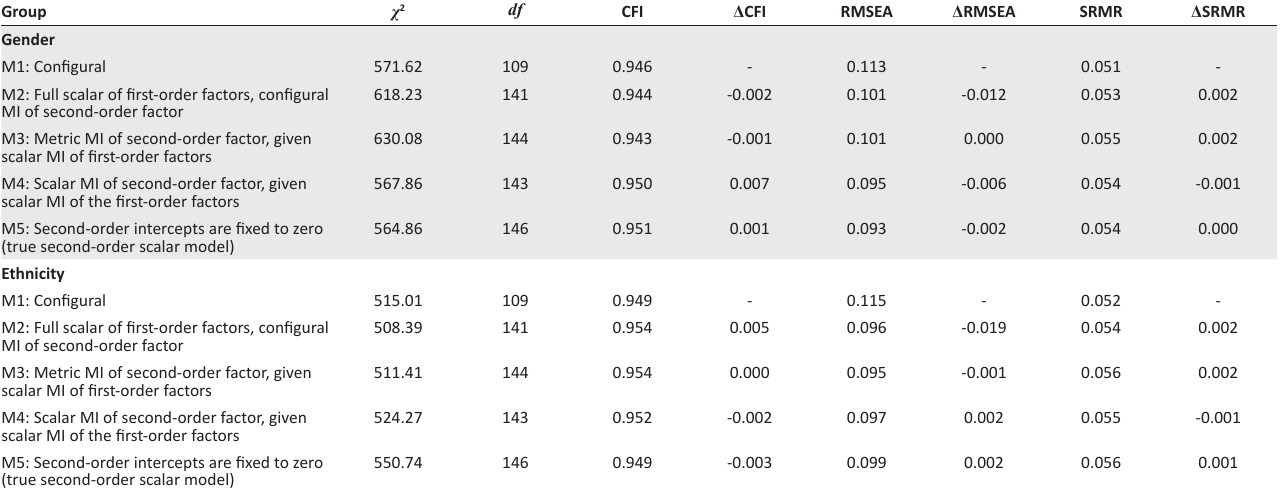
TABLE 3: Results of the second-order measurement invariance testing.